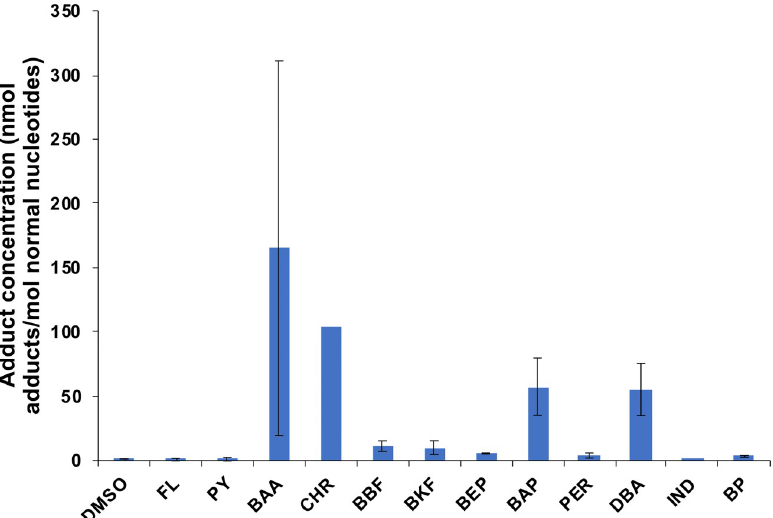
Fig 2. DNA adducts in the liver of fish injected with heavy PAH (4/5/6 rings) (2 replicates of each compound, except chrysene (CHR), where one of the replicates died (n = 1)). Data presented as average ± standard deviation. Dimethylsulfoxide (DMSO) represents the